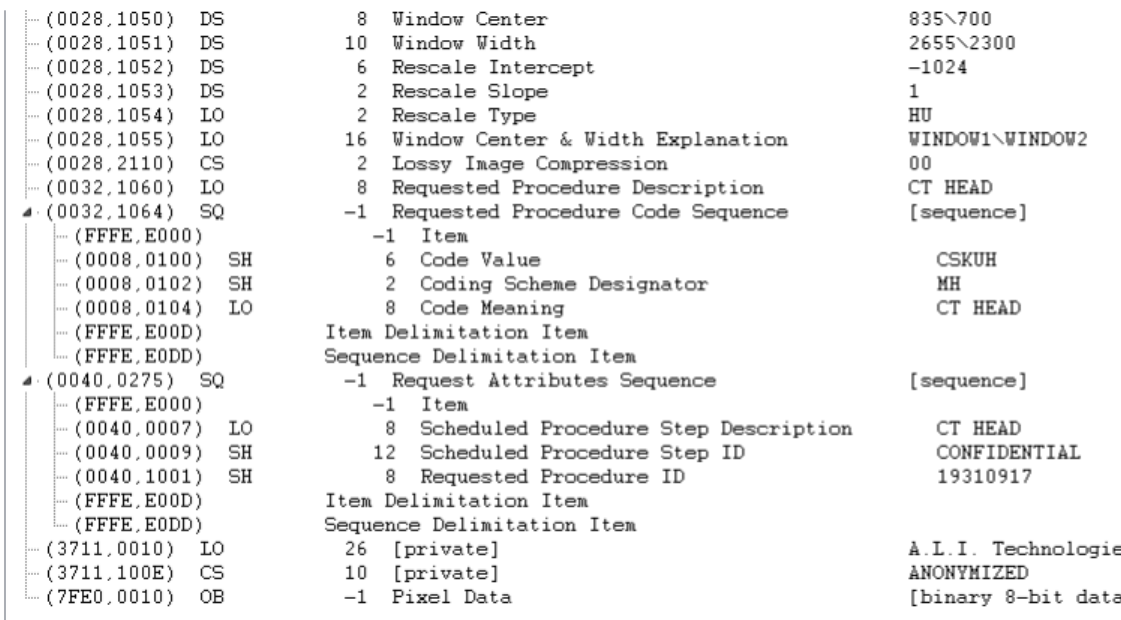
Figure A7. De-identified DICOM header data (part